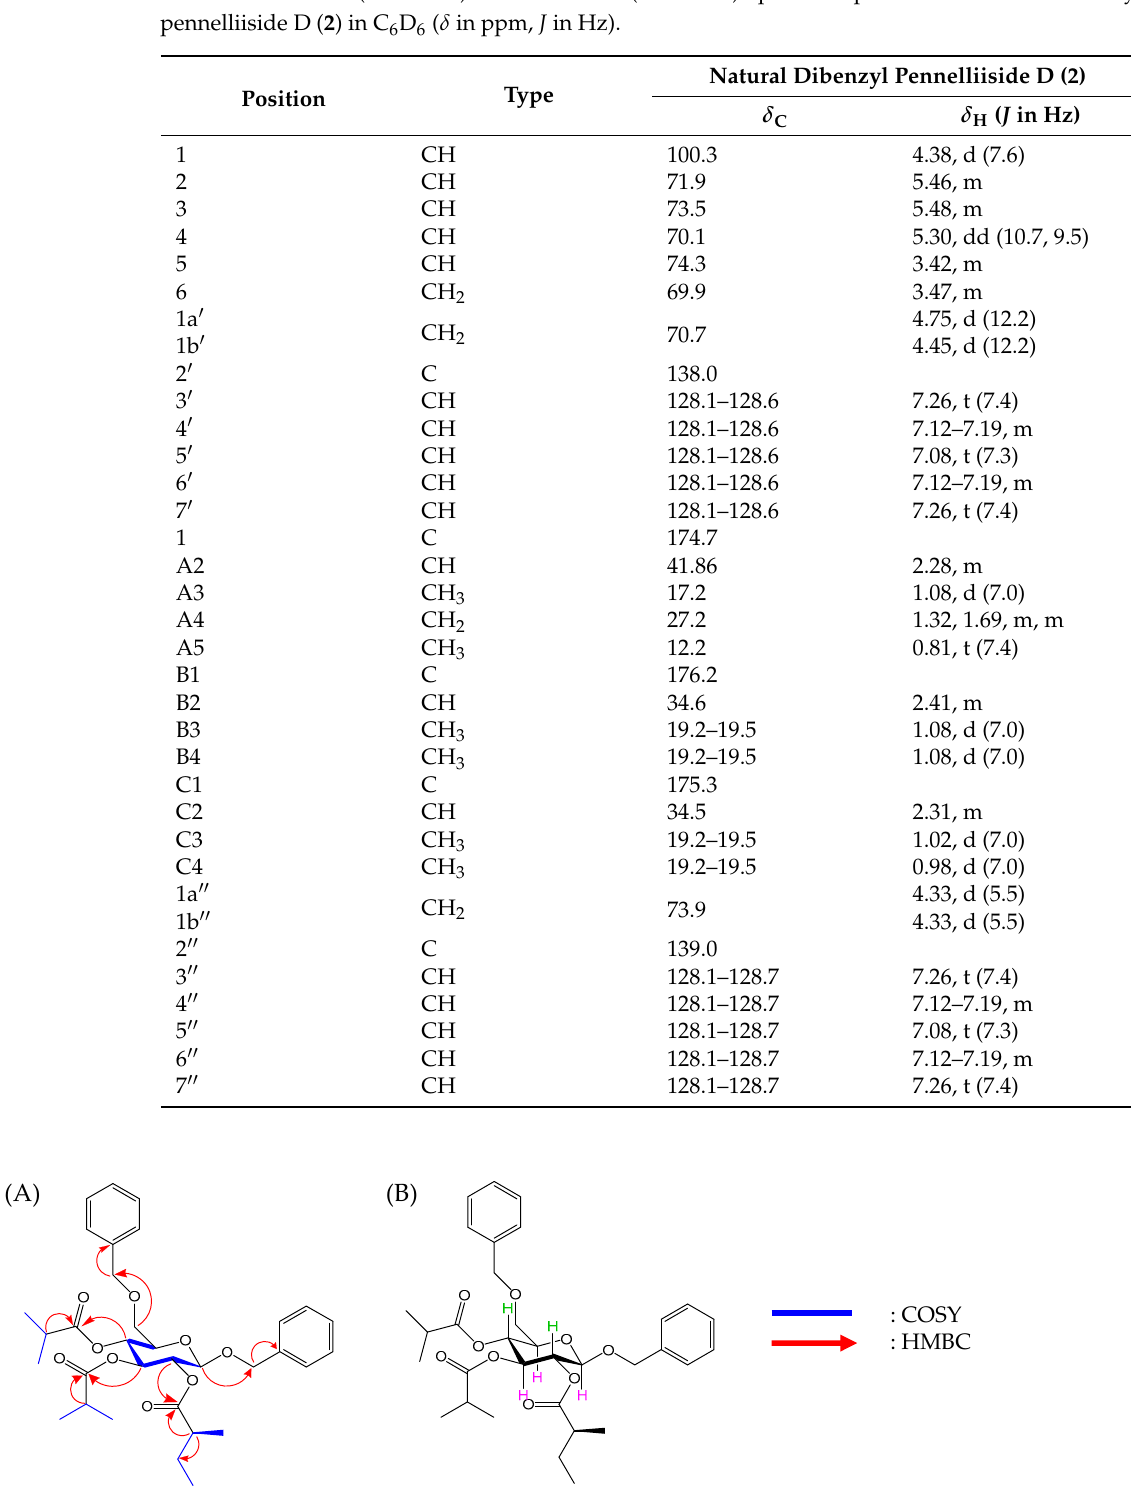
Table 1. 1 H NMR (500 MHz) and 13 C NMR (126 MHz) spectroscopic data of natural dibenzyl